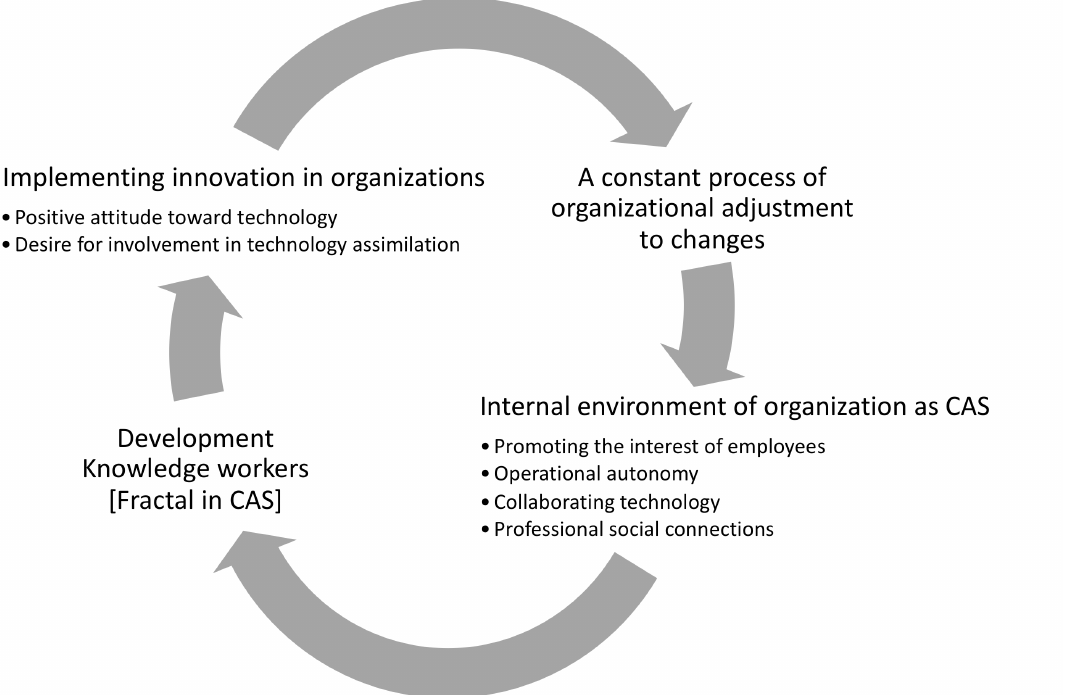
Fig. 3. A constant organizational process to adjust to innovation